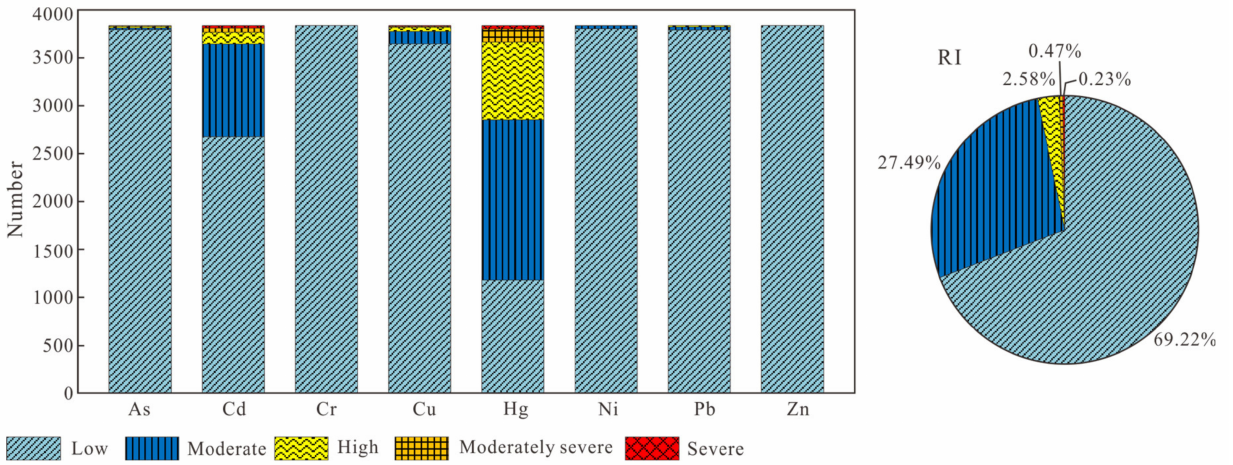
Figure 7. Potential Ecological Risk Classification of Heavy Metals in Surface